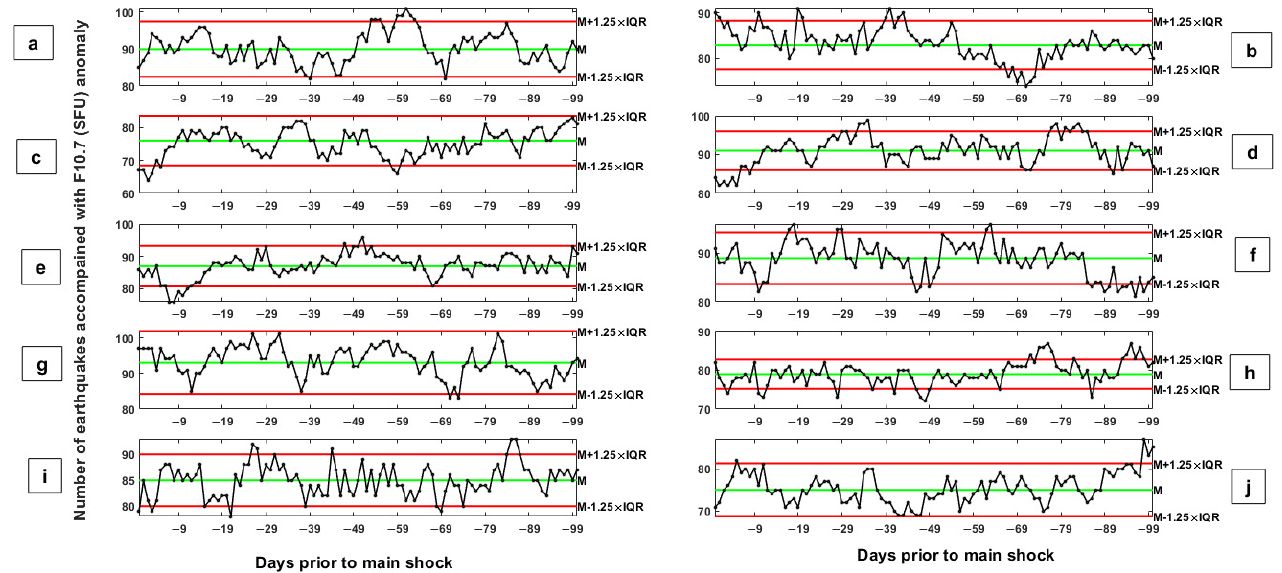
Figure 9. Panels ( a – j ) show results of 10 simulated earthquakes dataset. The y -axis in each panel indicates the number of simulated earthquakes accompanied by anomalous changes in the F10.7 index during the days prior to the simulated earthquakes. Median and higher and lower bounds are drawn as green and red horizontal lines, respectively. The allowed ranges are defined as M ± 1.25 × IQR , in which M and IQR are the median and the inter-quartile range parameters, respectively.